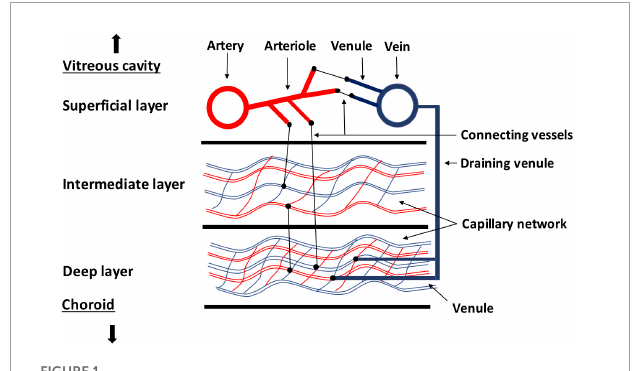
FIGURE1 Sketch of the different layers of retinal circulation. In the superficial layer, larger vessels, such as arteries, arterioles, and big veins are located. The capillary network is located in the intermediate and deep plexus with a higher vessel density in the deep plexus. Collecting venules are rising from the deeper plexus to the superficial plexus to drain to the larger veins.